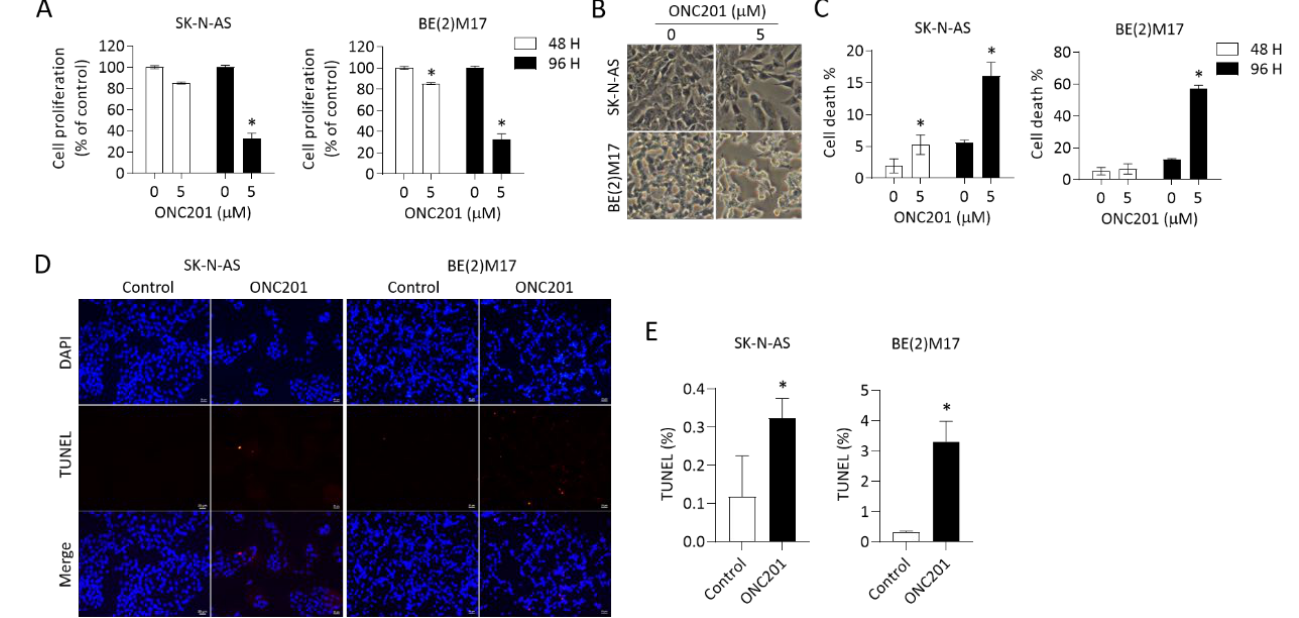
Figure 2. Effects of ONC201 on cell survival in NB cells: ( A ) SK-N-AS and BE(2)M17 cells were treated with ONC201 (5 μM) for 48 h and 96 h. The cell survival was detected by Resazurin assay. ( B ) Representative phase contrast images demonstrating cell density and morphological changes in NBs exposed to ONC201 for 48 h. Scale bar 50 μm. ( C ) After incubation with ONC201 (5 μM) for 48 h, cells were collected and stained by trypan blue solution. The percentage of trypan-blue-positive cells was quantified using flow cytometry. ( D , E ) Representative profiles of TUNEL staining (red) in control and ONC201-treated NB cells. DAPI (blue) was used as a nuclear counterstain. Scale bar 20 μm. ( D ) The apoptotic cells are expressed as the percentage of the number of TUNEL-positive cells over the number of DAPI-positive cells. All data are expressed as mean ± SD from triplicate experiments. * p < 0.05.